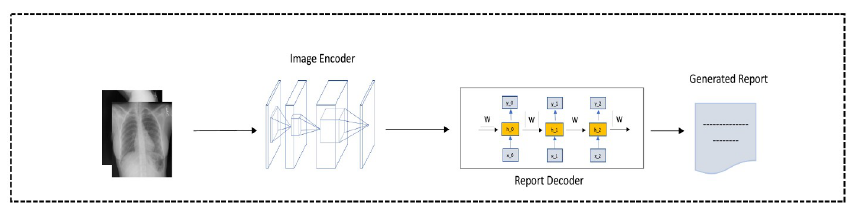
Fig 2. An encoder-decoder model. A CNN is used as encoder and an LSTM as decoder.